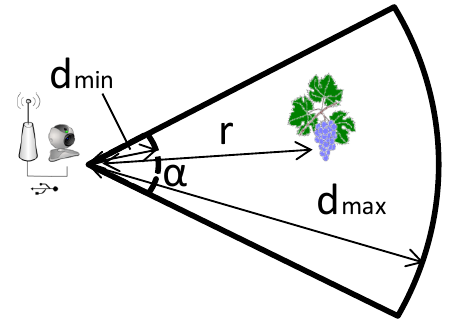
Figure 3. Sensing coverage of a wireless sensor